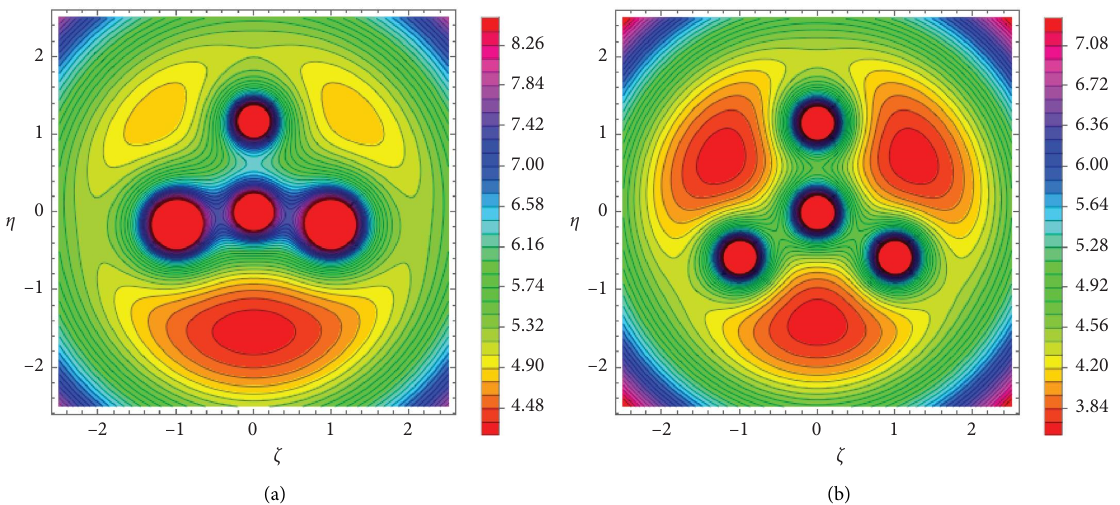
Figure 7: Case II: the evolution of zero velocity curves. (a) μ � 1 . 73878, (b) μ � 1.